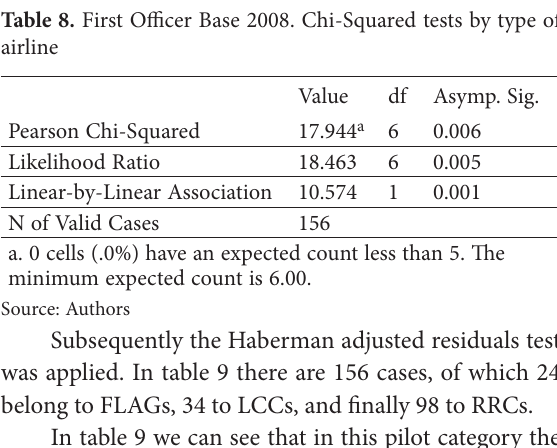
Table 8. First Officer Base 2008. Chi-Squared tests by type